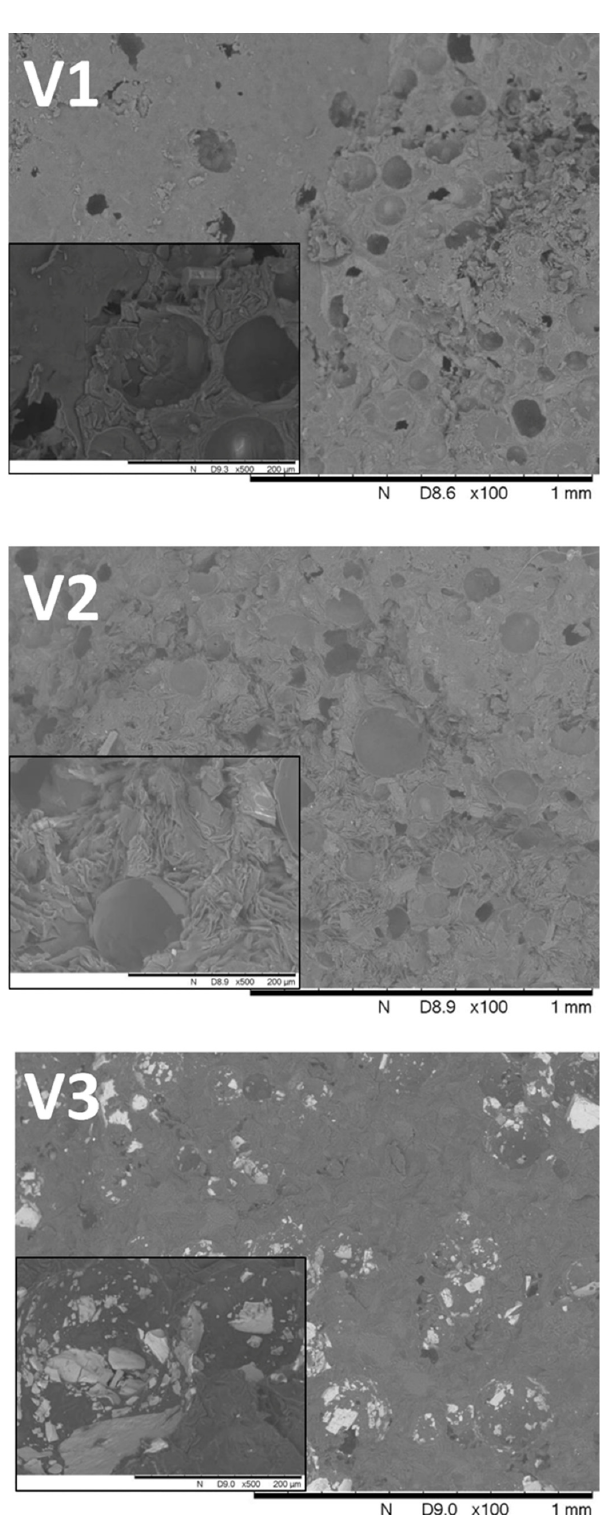
Figure 3. Scanning electron microscopy images of the broken surfaces of V1, V2, and V3. Different locations of the API i can be observed in different matrices. The insets show magnified images of the cavities with verapamil crystals. In V1 and V2, verapamil particles were dispersed through the matrix, while in V3, the white verapamil crystals appeared in the inner surfaces of the cavities. The scale bar of the insets is 200 μ m.